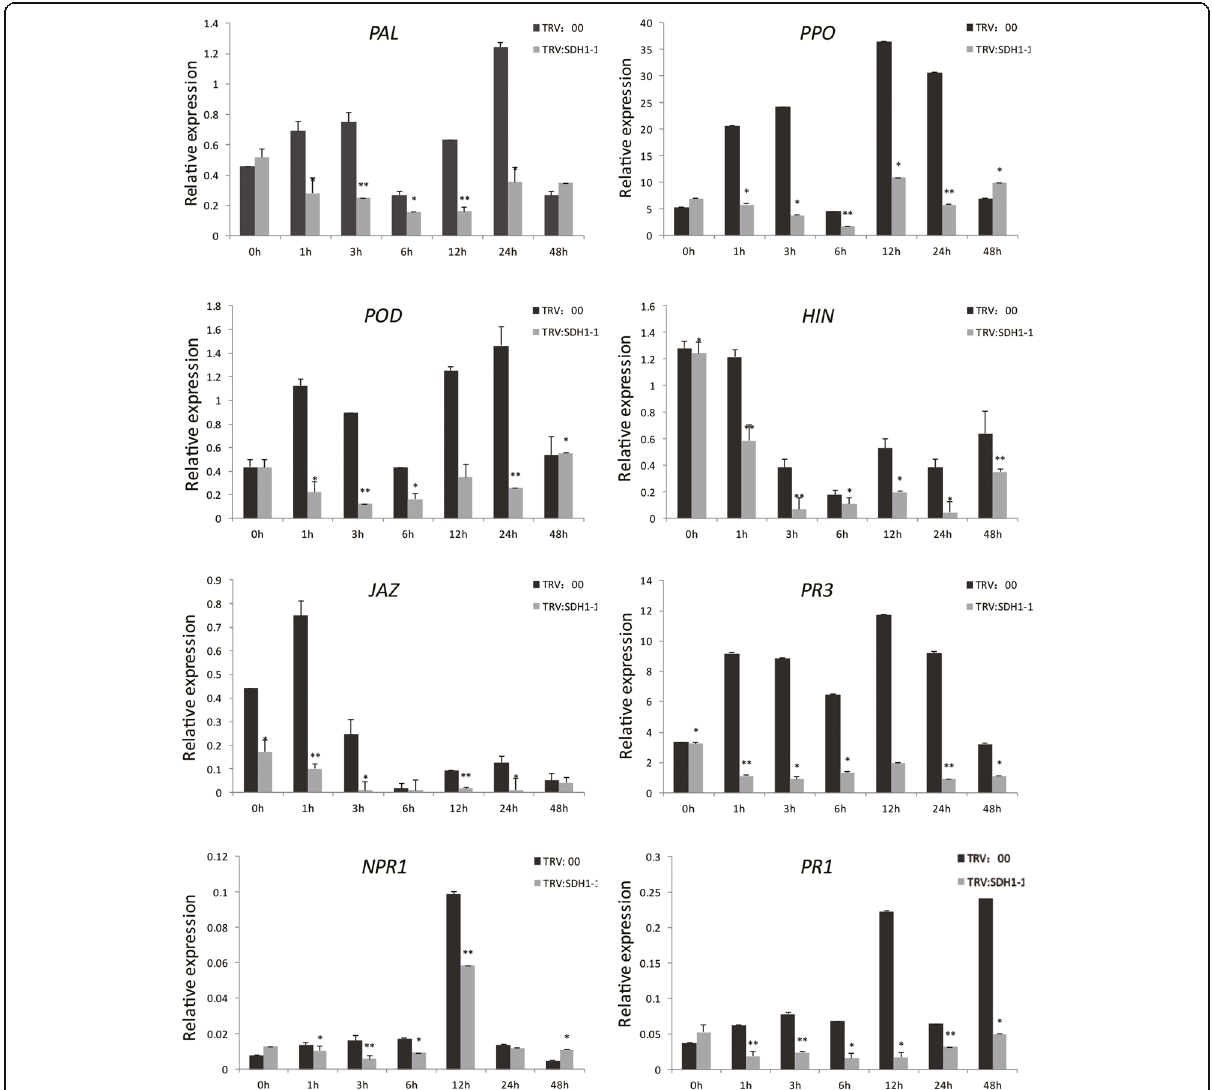
Fig. 3 Detection of expression levels of disease resistance-related genes in GhSDH1 – 1 -silenced and control cotton plants. Total RNAs were extracted from GhSDH1 – 1 -silenced and control cotton plants after treatment with V. dahliae , and roots were harvested at 0, 1, 3, 6, 12, 24, and 48 hpi, respectively. The expression levels of resistance-related genes were determined by qRT-PCR. Error bars represent the standard deviation of three biological replicates. Asterisks indicate statistically significant differences, as determined by Student ’ s t-test (* P < 0.05; ** P <